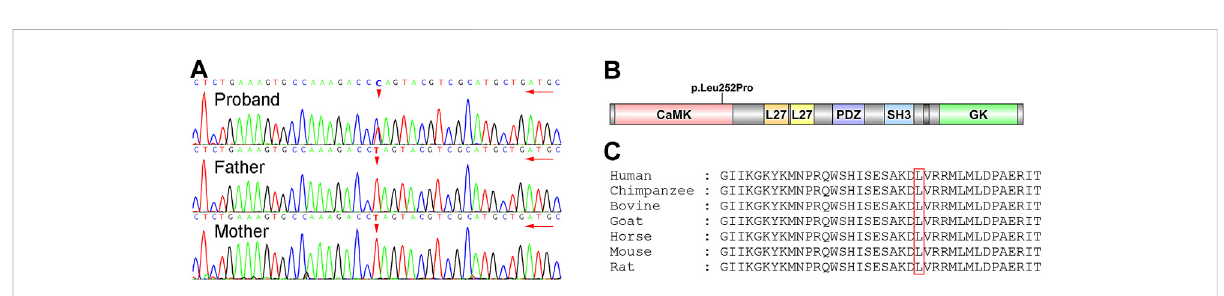
FIGURE 3 Identi fi cationofthenovel CASK mutation. (A) resultsofSangersequencing.Theprobandwasheterozygousstatuswithc.755T >